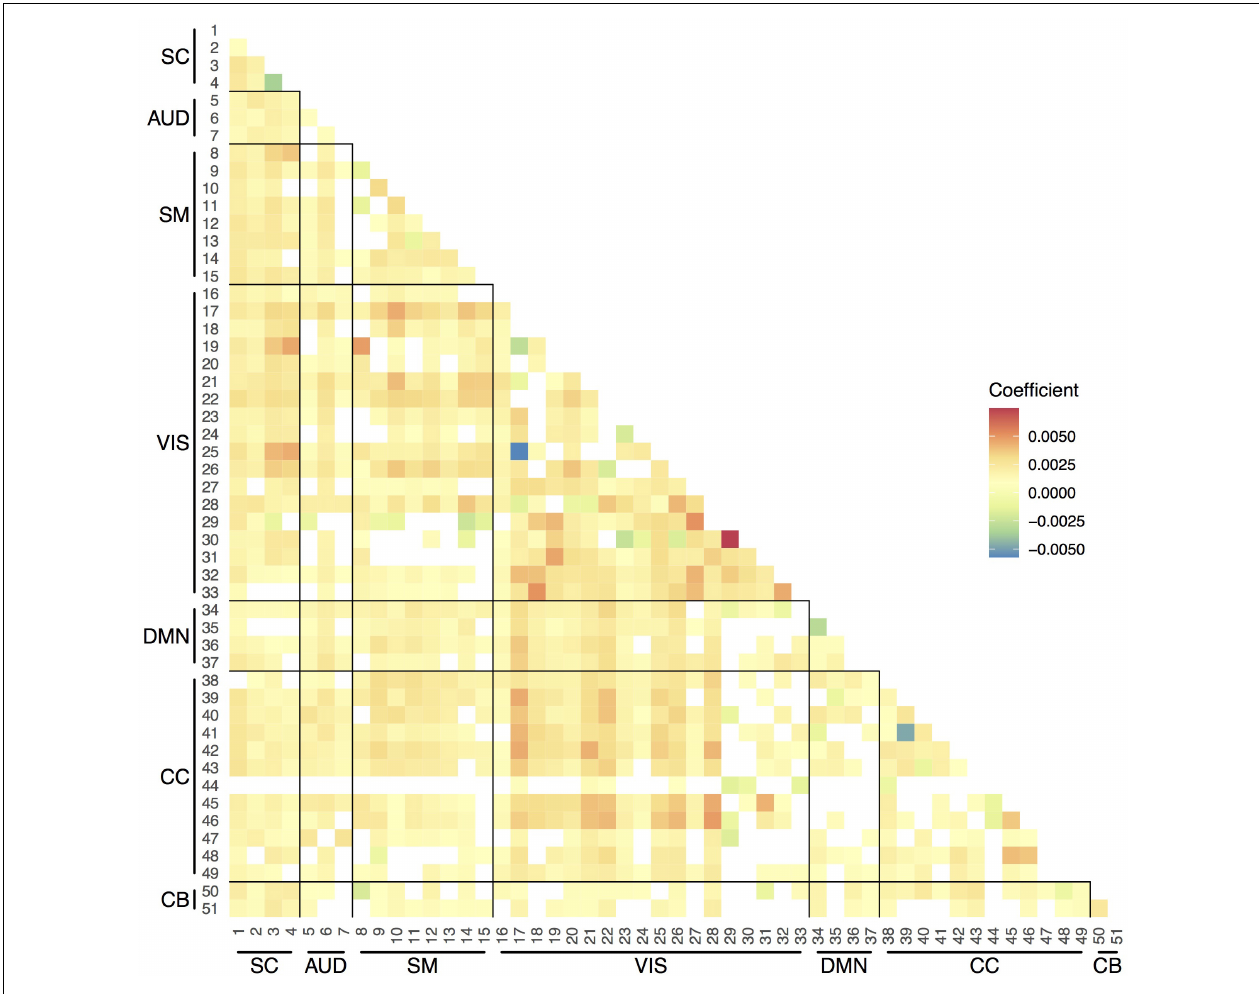
FIGURE 5 | Strength of the associations between age and variability in pairwise functional connections between components. Linear mixed-effects models adjusted for sex (random effect: subject). Only the results that survived the false discovery rate (FDR) multiple comparison correction threshold of pFDR = 0.05 are shown here. SC, subcortical network; AUD, auditory network; SM, sensorimotor network; VIS, visual network; DMN, default-mode network; CC, cognitive control network; CB, cerebellar